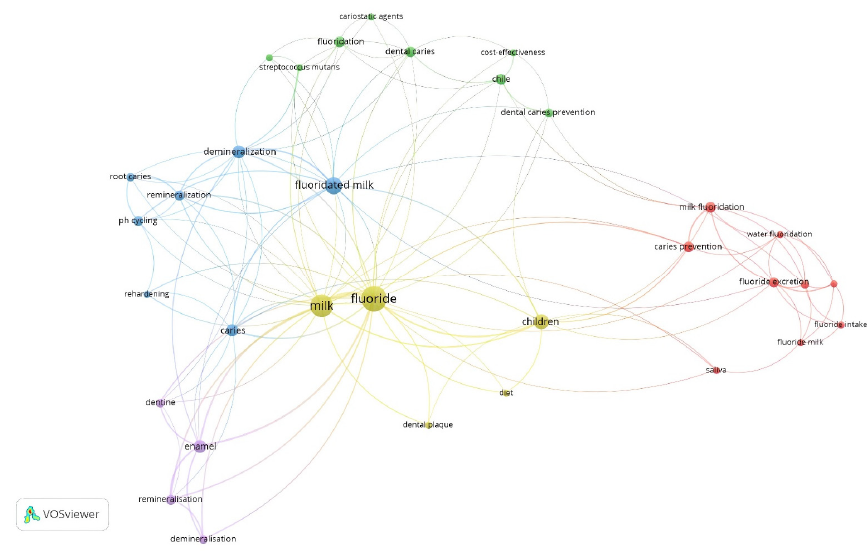
Figure 6. Network visualization of co-occurrence of author keywords.